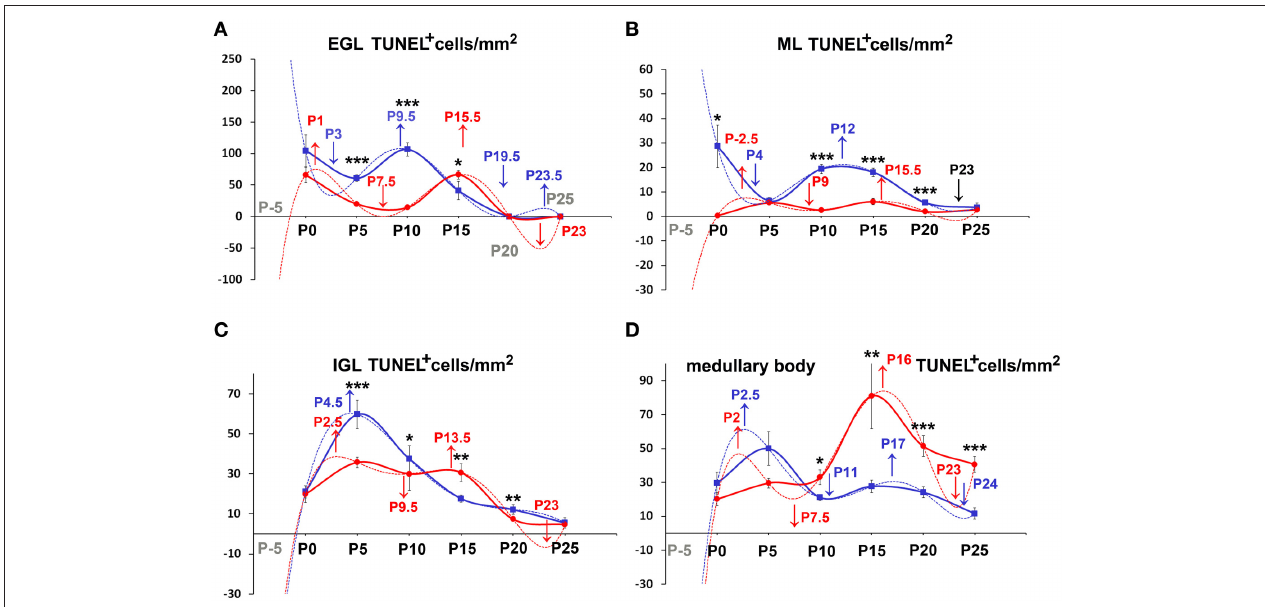
FIGURE 7 | Descriptive graphs (solid lines) and correlation curves (dashed lines) of normalized ApoCD. Graphs highlight the trends and differences across genotypes of normalized ApoCD (TUNEL + cells/mm 2 ) in the four cerebellar compartments defined in this study (EGL, ML, IGL, and medullary body). Postnatal ages corresponding to the minima and maxima of correlation curves are indicated with colored letters and upwards or downwards arrows. Blue and red lines or letters/arrows refer to reln + / + and to reln − / − mice, respectively. Black letters for postnatal ages and arrows indicate reference to both genotypes (B) . Postnatal ages in gray (x axis) indicate the time points of correlation curves outside the sampling interval (extrapolations). In the EGL (A) , ApoCD was higher in normal mice at P5 and P10, but was then overtaken by that in reln − / − mice at P15, i.e., immediately before the complete disappearance of this temporary cortical layer. The percentages of apoptotic cells were not different between genotypes at any developmental age. In the ML (B) , reln + / + mice displayed higher ApoCD at P0, P10, and P20. ApoCD was not statistically different at P5 and P25, but reln − / − mice had a higher percentage of TUNEL + cells at P5 ( reln + / + 0.06 ± 0.02, reln − / − 0.23 ± 0.02, P < 0.001). In the IGL (C) , ApoCD was higher in reln + / + mice at P5, P10 and P20 (blue solid line), but surpassed by that calculated in mutants at P15 (red solid line). At P25, differences among genotypes were not statistically significant. The percentages of TUNEL + cells were significantly higher in reln − / − mice only at P15 ( reln + / + 0.18 ± 0.02, reln − / − 1 ± 0.15, P < 0.05) and P20 ( reln + / + 0.08 ± 0.02, reln − / − 0.24 ± 0.03, P < 0.01). In the medullary body (D) , Apo CD was higher in reln − / −